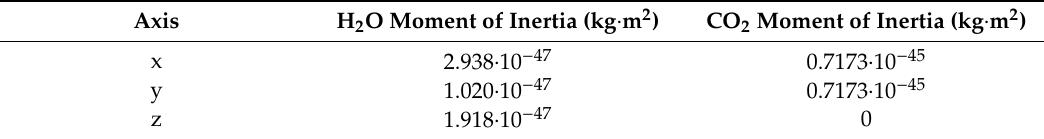
Table 2. Moments of inertia for H 2 O and CO 2 models